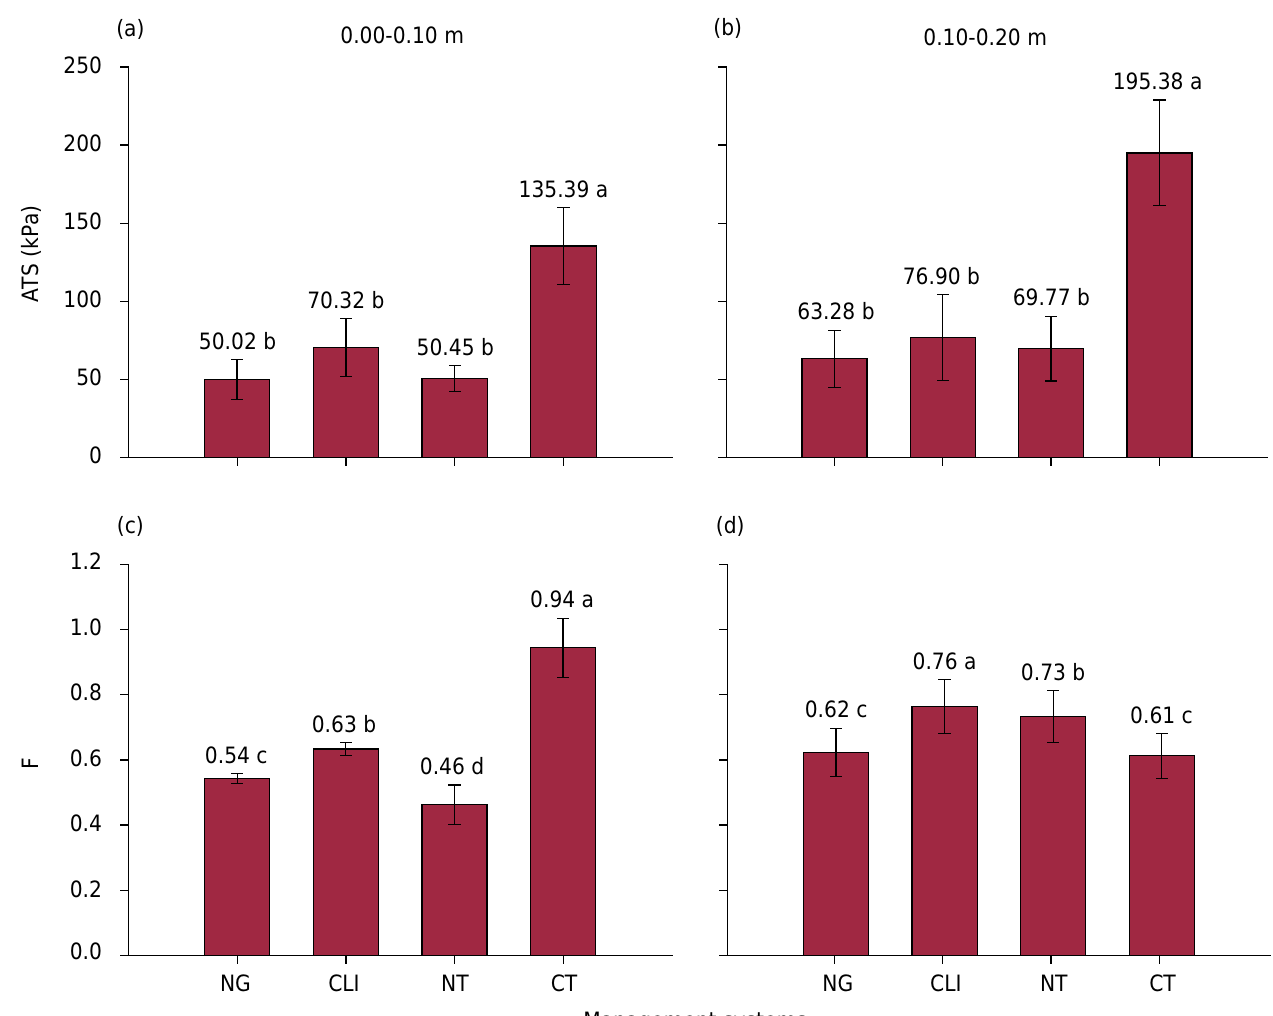
Figure 5. Aggregate tensile strength (ATS) (a, b) and friability (F) (c, d) of an Albaqualf under different management systems in the 0.00-0.10 and 0.10-0.20 m layers. NG: native grassland; CLI: crop-livestock integration; NT: no-tillage; CT: conventional tillage system. ns: not significant at 5 %. Means followed by the same lowercase letter in a column were not significantly different by Duncan’s test at 5 %. Vertical bars indicate the standard